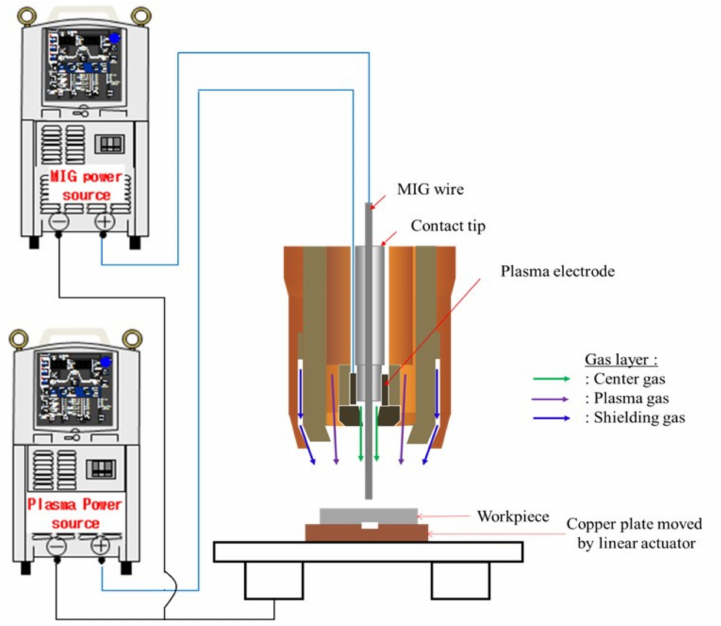
Figure 1. Schematic illustration of plasma MIG welding system reprinted with permission from ref [14]. Copyright 2022 Springer